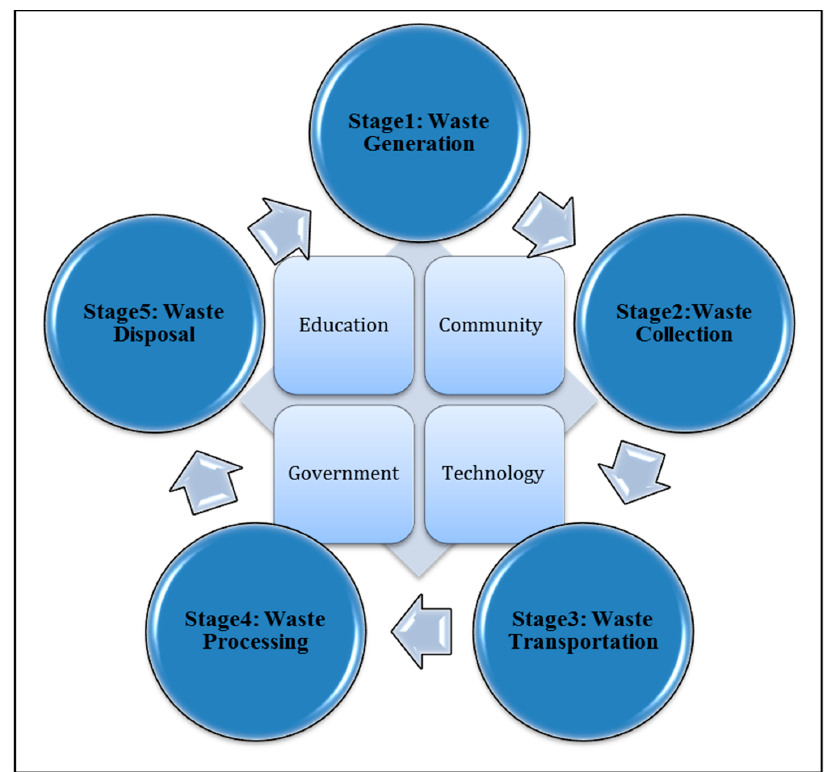
Figure 5. Integrated approach for organic waste management.